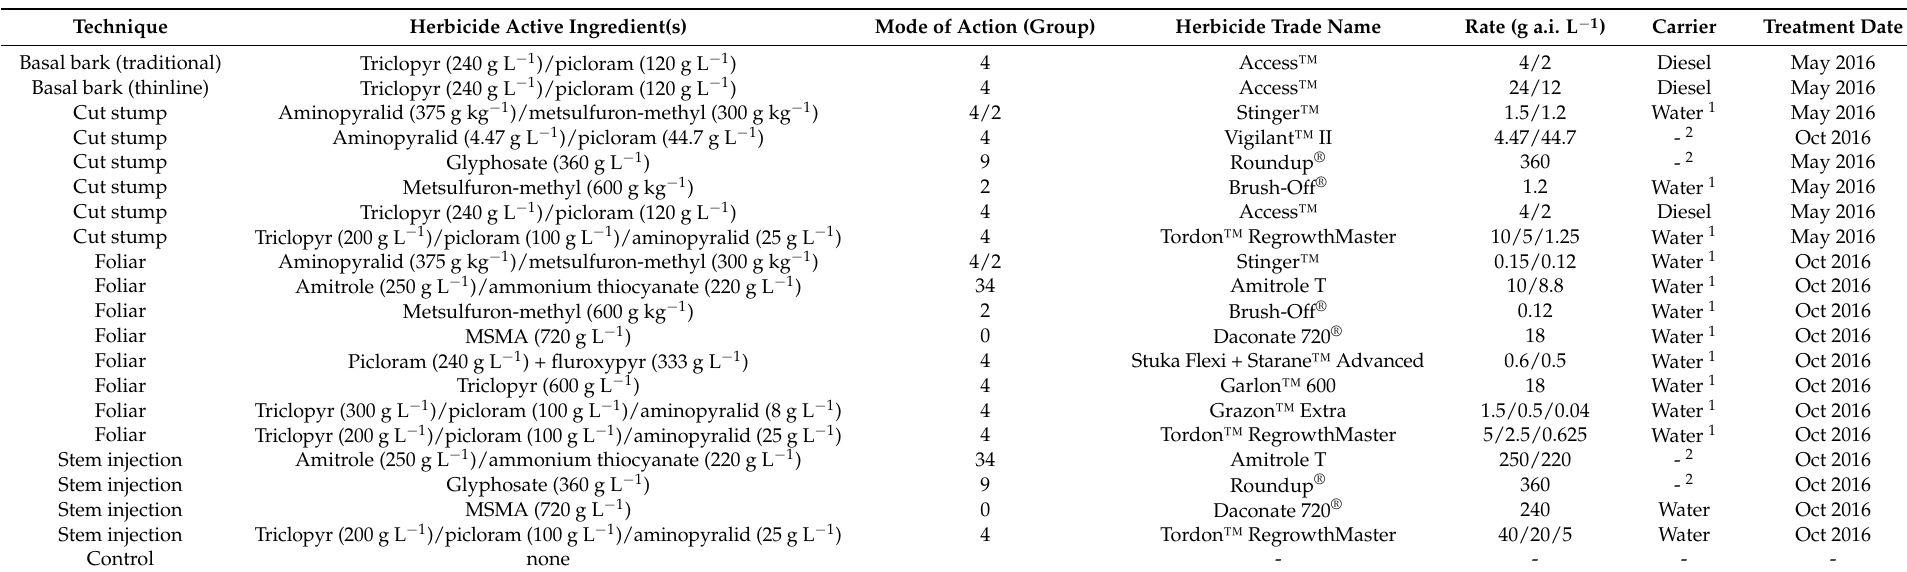
Table 1. Application techniques and herbicides screened for C. uruguayanus control efficacy in Experiment